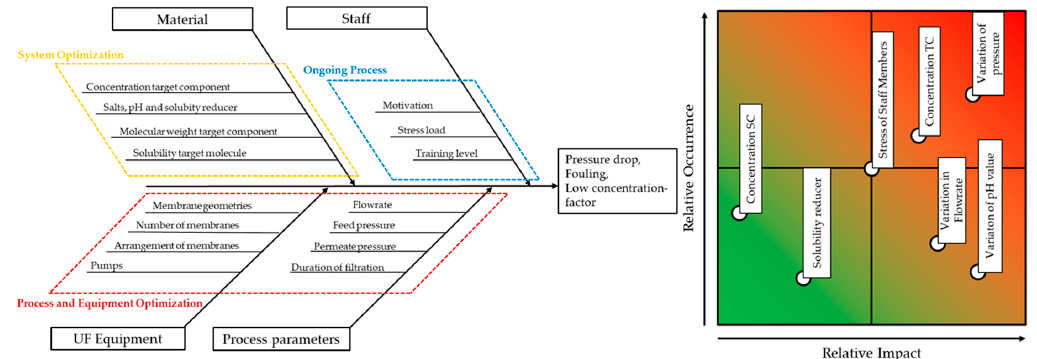
Figure 2. Quality-by-Design (QbD) assessment for ultrafiltration (UF) and diafiltration: Ishikawa diagram and Failure-Mode-Effect-Analysis (FMEA).